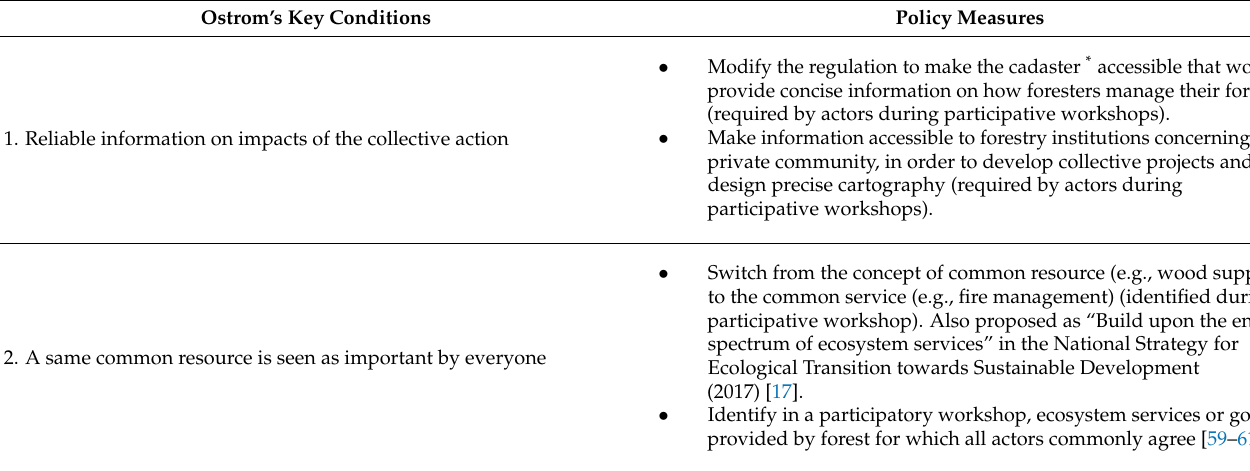
Table 4. Proposition of policy measures for the emergence of Ostrom’s key conditions required for local stakeholders to self-organise to solve collective action problems in managing common-pool